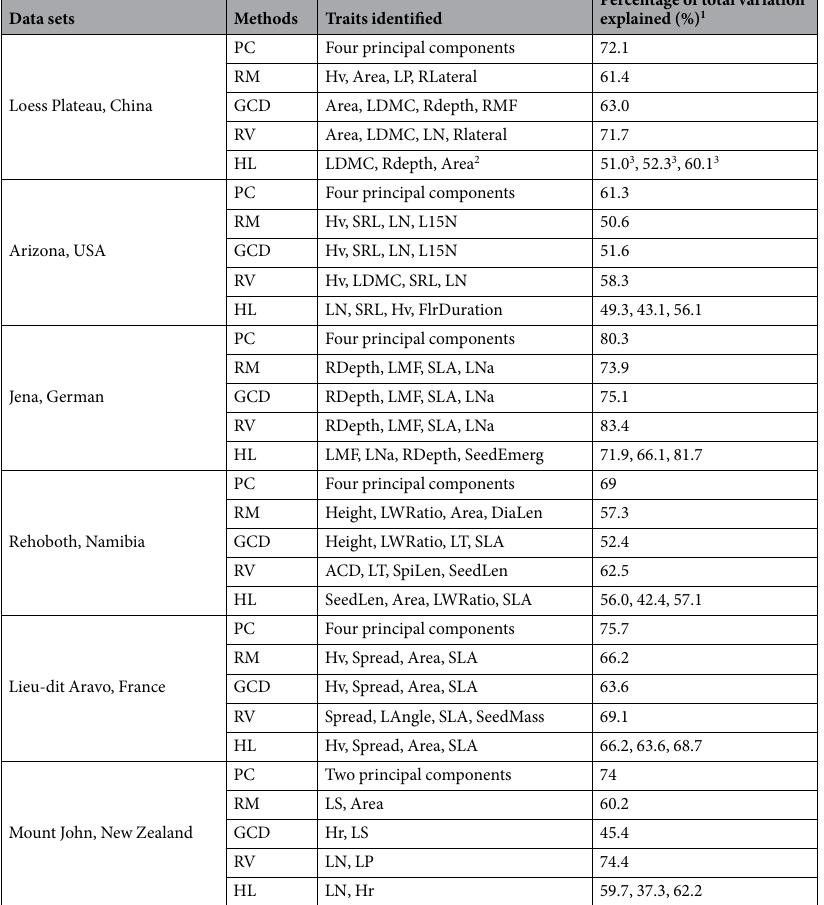
Table 1. The subsets of traits determined by the ordination axis-based and trait selection methods. See the abbreviations for traits in the Table S2 in the Supplementary Information. 1 For the methods of PC, RM and RV, the percentage indicates the explained information of original trait matrix. For the GCD method, the percentage indicates the explained information of reserved principal components. 2 In the Loess Plateau data set, area of a leaf (Area) had the highest loadings in the third and fourth principal components (Figure S1). 3 The three numbers in the HL row were quantified using the RM coefficients, GCD and RV